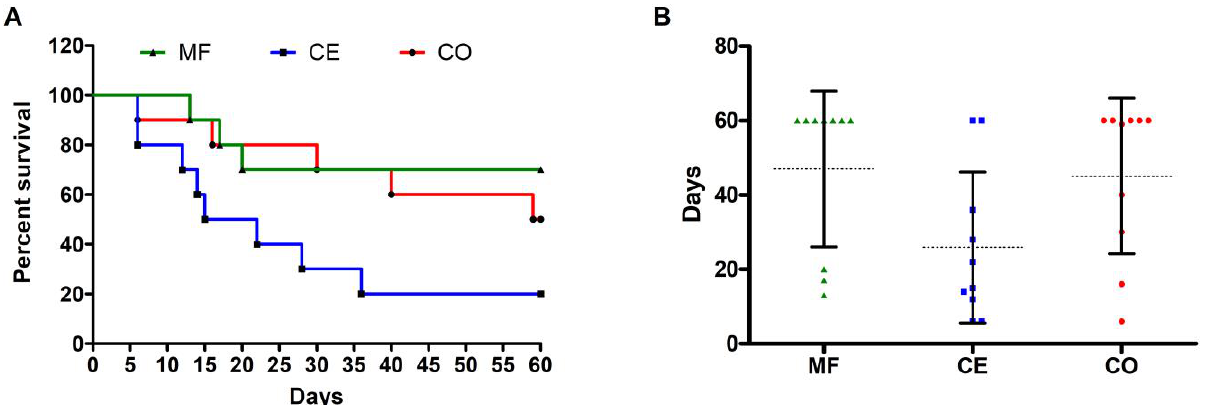
Figure 2. ( A ) The survival curves of the 3 tested groups expressed in the number of incubation days before bacterial leakage. ( B ) A scattered dot plot for the average days till the bacterial leakage in each sample in all groups. The dotted line represents the mean of each group and error bars represent